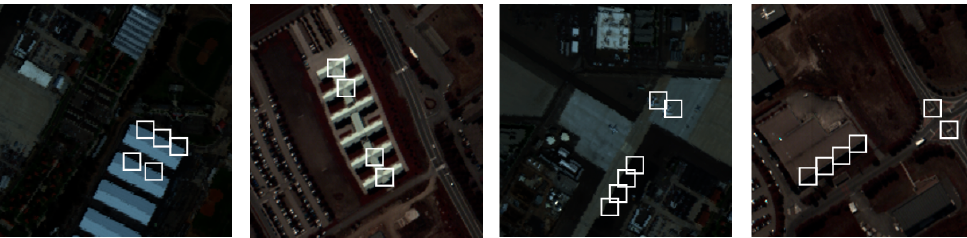
Figure 1. Similar or repeating patches (denoted by small white squares) in HSI composite images with bands 28, 19, and 10 in red green, and blue, respectively.